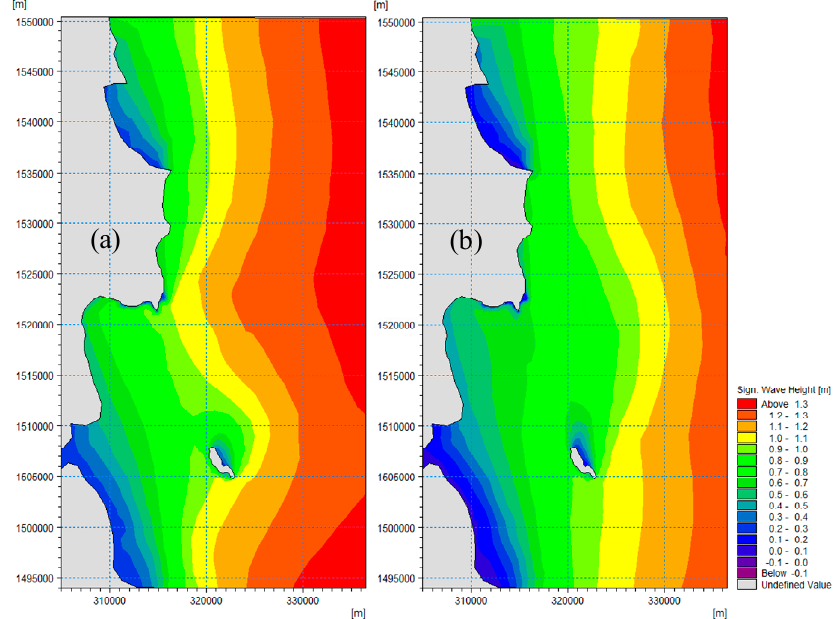
Figure 5. The results of wave field: ( a ) low tide and ( b ) high tide.